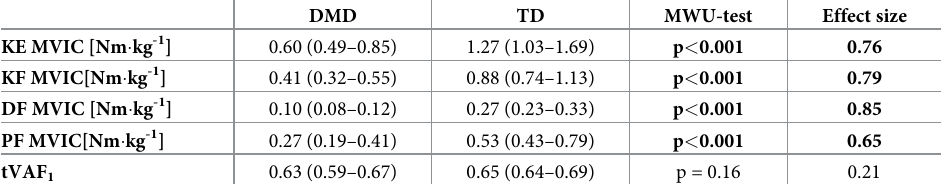
Table 2. Group differences in MVICs and tVAF 1 between DMD and TD from the MWU-test ( α = 0.01) and their r effect sizes. Values are given in medians and 25 th and 75 th centiles. DMD